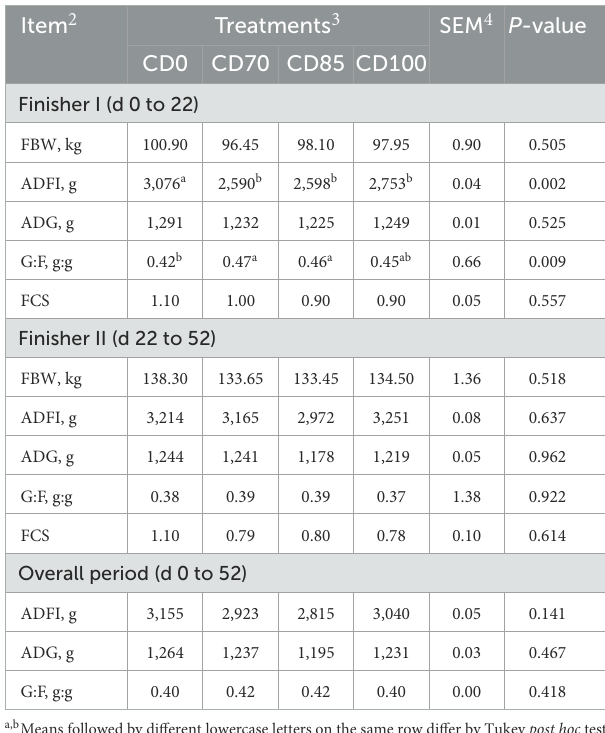
TABLE 2 Effect of β -mannanase supplementation in diets containing xylanase-phytase and reduced metabolizable energy on performance and fecal consistency score in finisher pigs 1 .